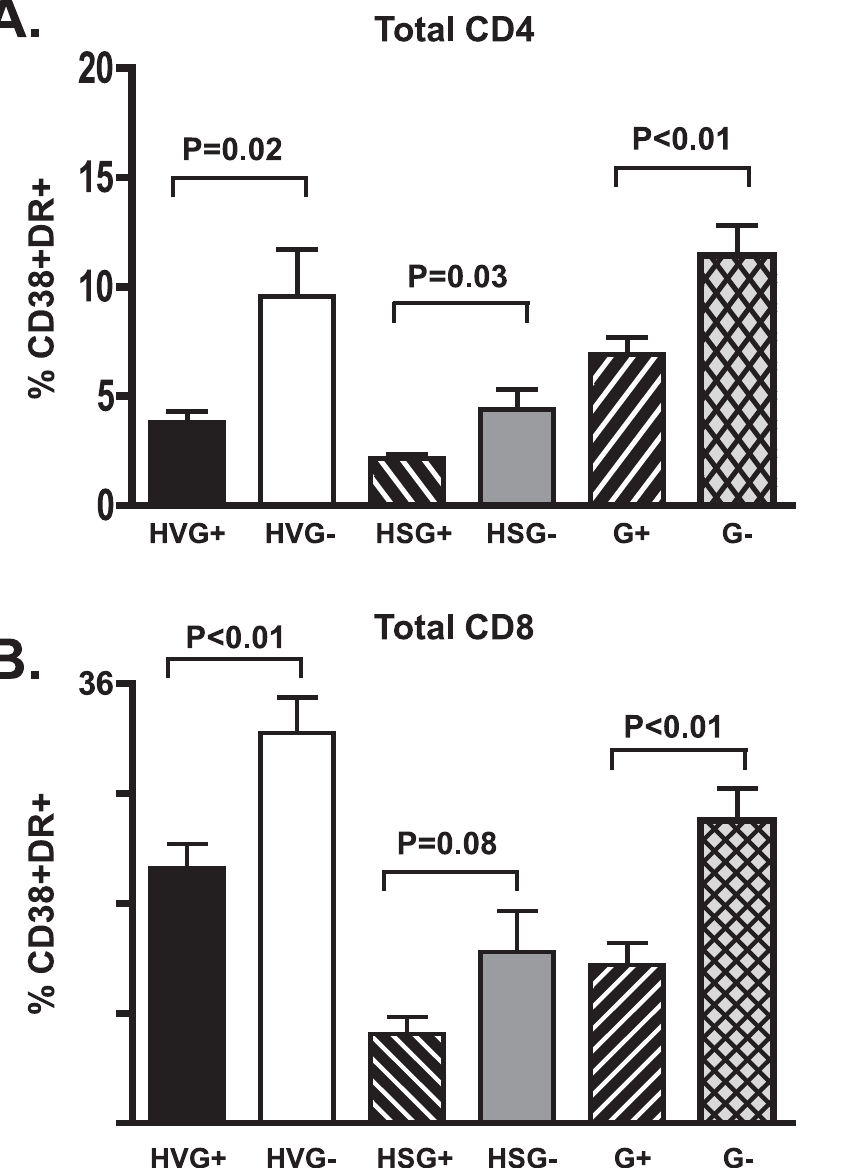
Figure 1. GBV-C is associated with reduced CD4 + and CD8 + T cell activation in HIV-infected individuals. The percentage of CD4 + (A) and CD8 + (B) T cells expressing CD38 and HLA-DR differed between GBV-C viremic (G + ) subjects and those without GBV-C viremia (G-). Results of subjects not receiving combination antiretroviral therapy (HIV viremic; HV) or those with suppressed HIV RNA on therapy (HS) and statistical evaluation are